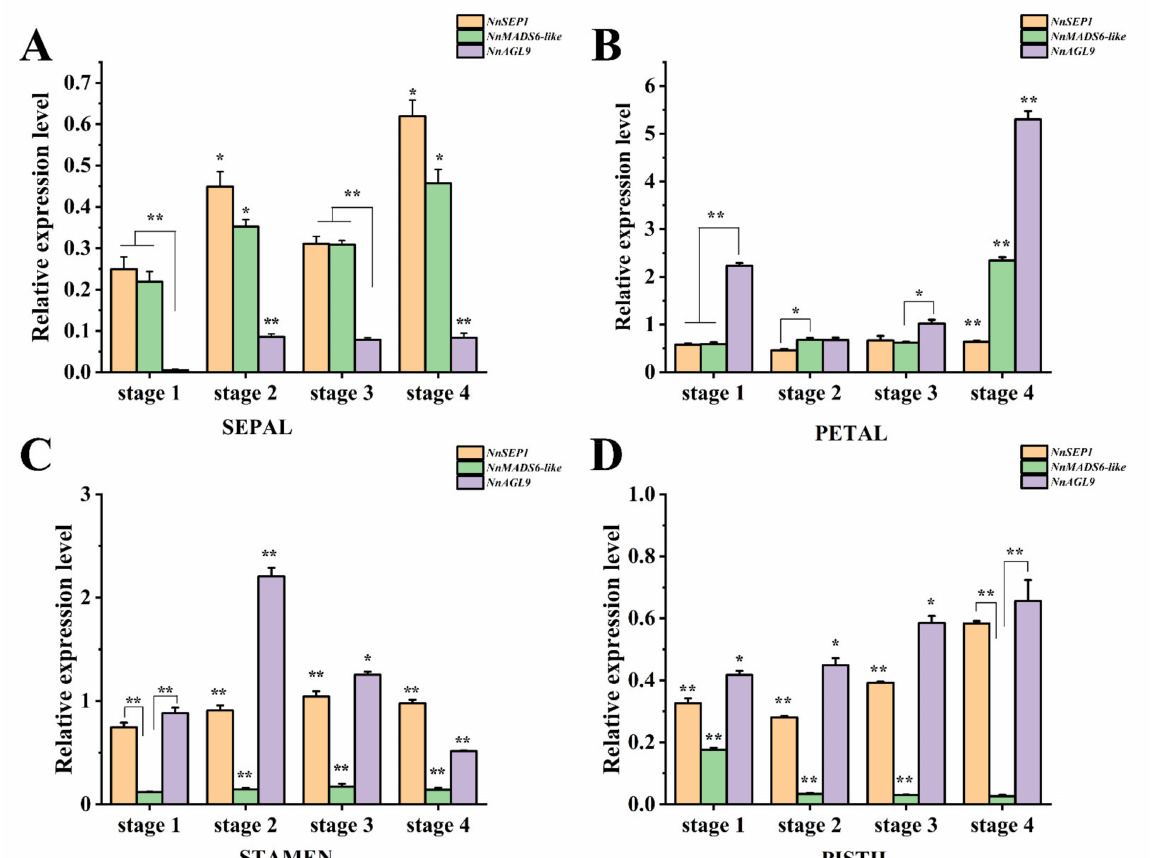
Figure 6. The expression pattern of three genes in different tissues at different floral development stages of N. nucifera. ( A ) Expression pattern of three genes in sepals. ( B ) Expression pattern of three genes in petals. ( C ) Expression pattern of three genes in stamens. ( D ) Expression pattern of three genes in pistils. The genes expression was detected using the RT-PCR method and NnACTIN as the internal reference gene. All data are means of three replicates, with error bars indicating standard deviations. The values are means ± SD of triplicate analysis (* indicating p < 0.05, ** indicating p <